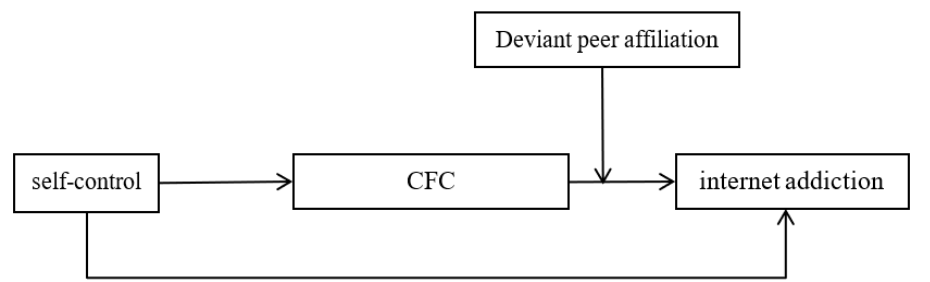
Figure 1. The proposed mediated moderation model. Note: CFC = Consideration of Future